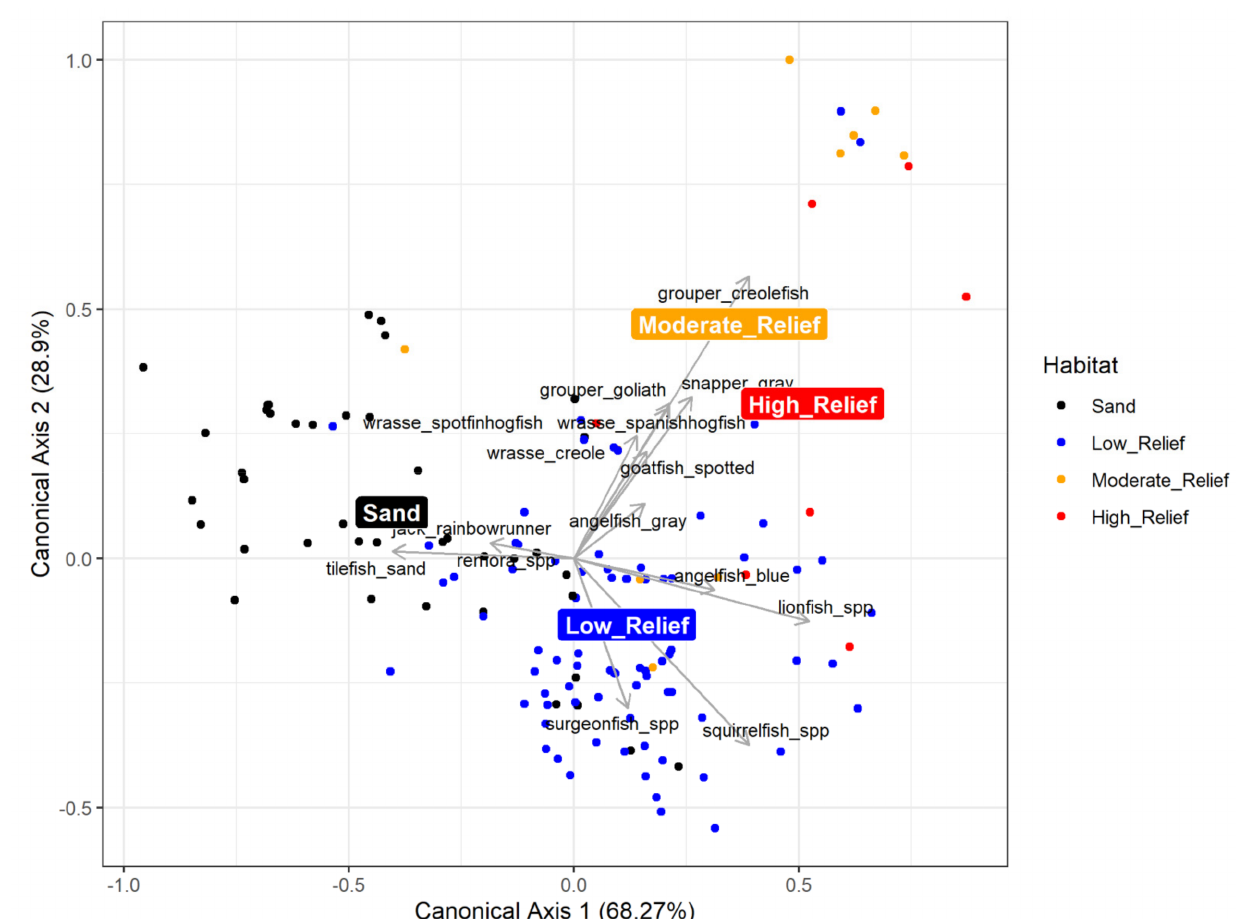
Figure 14. Canonical analysis of principal coordinates (CAP) plot showing the top 15 species that differentiate communities among four habitat types: sand, low relief rock, moderate relief rock, and high relief rock habitats. Points represent individual observations of a habitat type, and vectors represent the species correlation vectors. Additionally, the centroids for each habitat type are